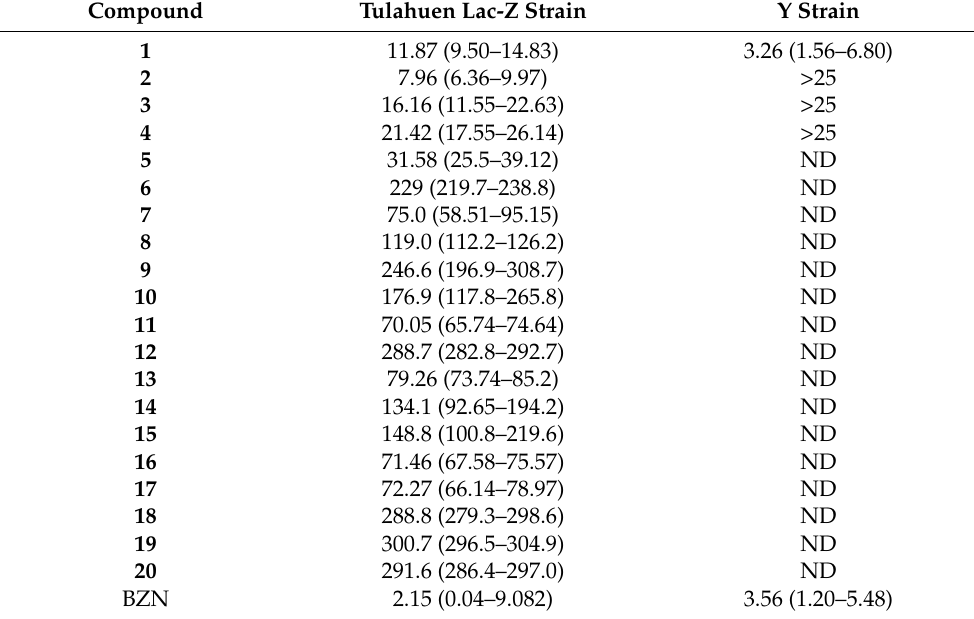
Table 1. In vitro antitrypanosomal activity (IC 50 values, in µ M) of neolignans 1 – 20 against amastigotes of the T. cruzi Tulahuen lac-Z and Y strains after 72 h. 95% confidence limits are given in parentheses. Compound Tulahuen Lac-Z Strain Y